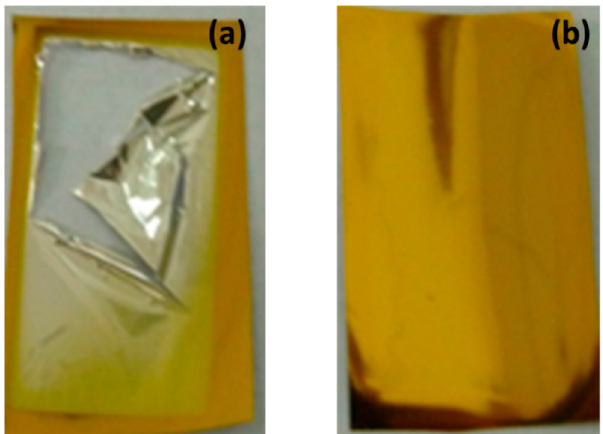
Figure 8. Images of the Kapton/Al samples ( a ) uncoated and ( b ) with the 360 nm-thick siloxane coating after the atomic oxygen irradiation test.